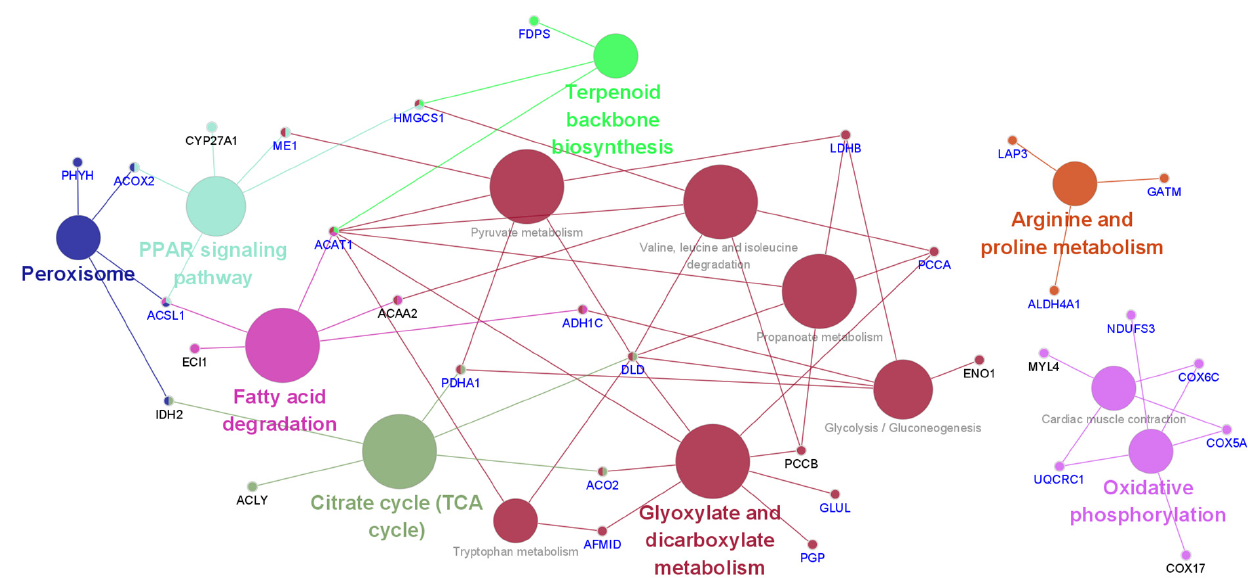
Figure 4. Effect of early heat exposure on the KEGG pathway of genes encoding differentially expressed proteins under acute heat stress. Blue-colored gene names: significantly altered by acute heat stress compared with the control but alleviated by early heat